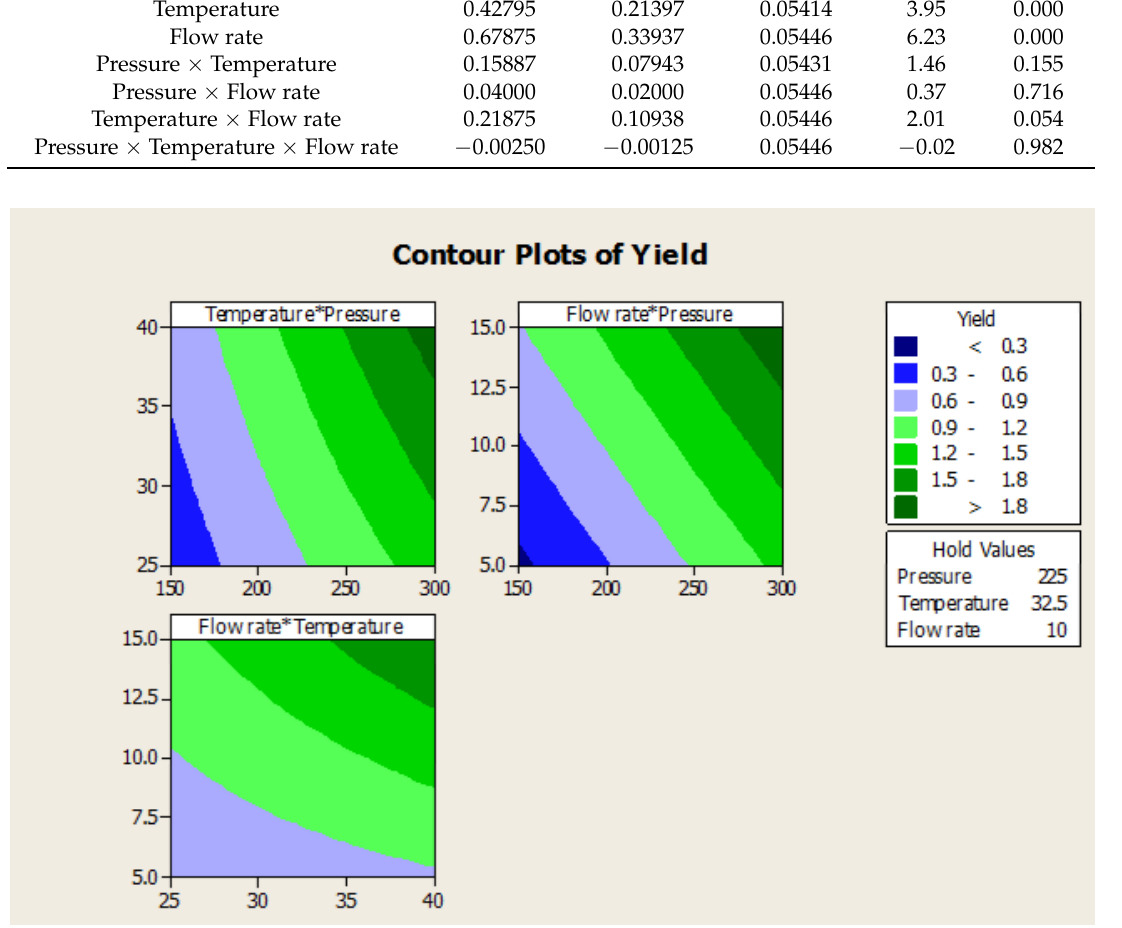
Figure 10. Surface plots of yield vs. pressure, temperature, and flow rate. The three factors of pressure, temperature, and flow rate were shown to have direct effects on the yield with p < 0.05, hence the pressure, temperature, and flow rate are significant factors that influence the yield. While a combination of temperature ‐ flow rate affects the yield to a certain extent